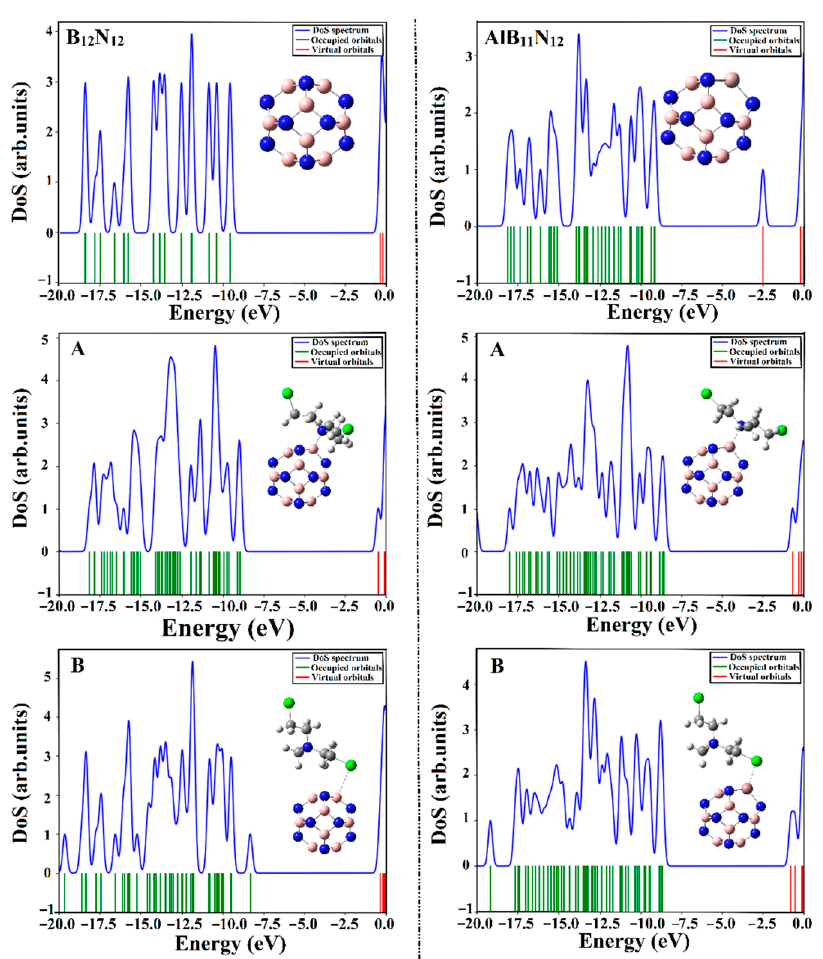
Figure 8. Density of states (DOS) plots for the B 12 N 12 and AlB 11 N 12 nanocarriers before and after the adsorption process of CM within the CM ∙∙∙ B 12 N 12 and ∙∙∙ AlB 11 N 12 complexes within configurations A and B.